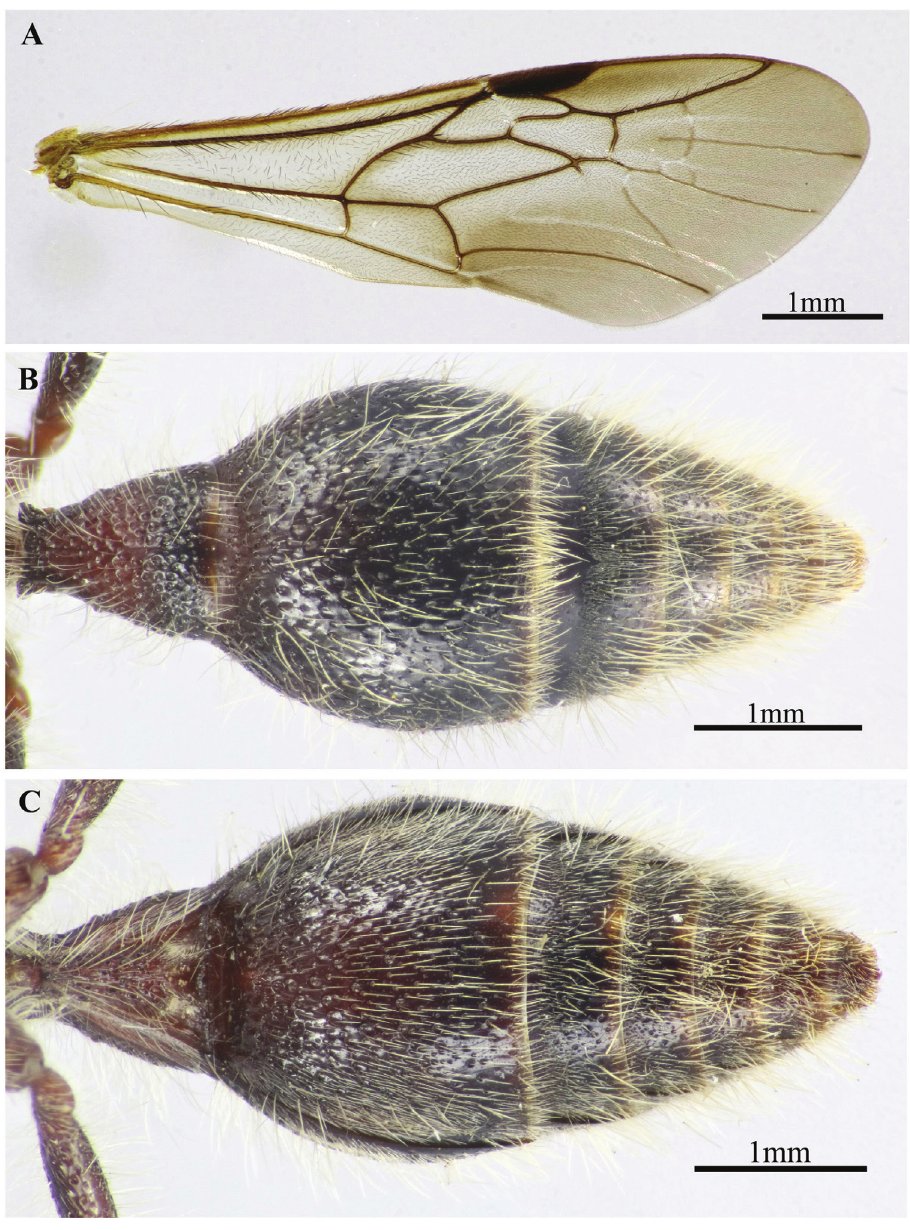
Figure 17. Pseudophotopsis mascatiana Invrea (Male) A right fore wing B, C metasoma, dorsal and ven- tral views,